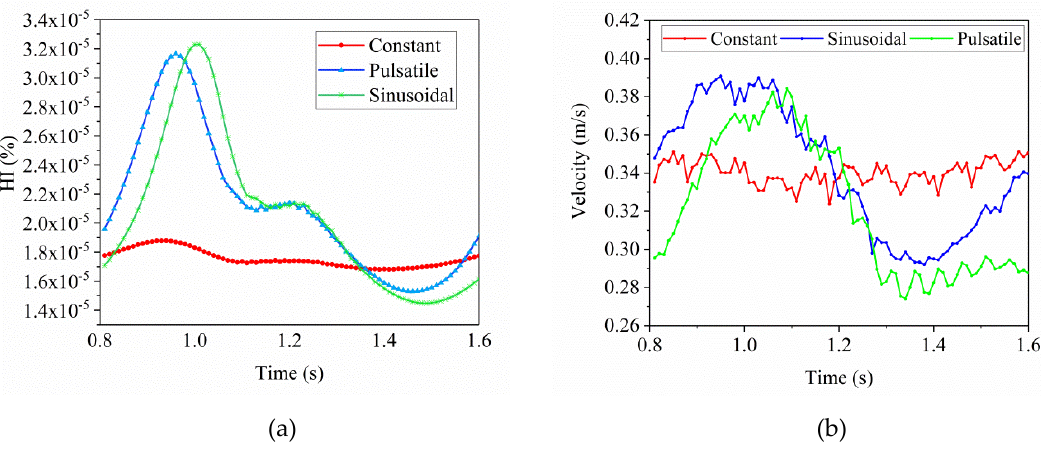
Figure 12. ( a ) Changes in hemolysis index (HI) under the three speed patterns. ( b ) Blood velocity in the spiral groove of the hydraulic bearing of the blood pump varied with time.